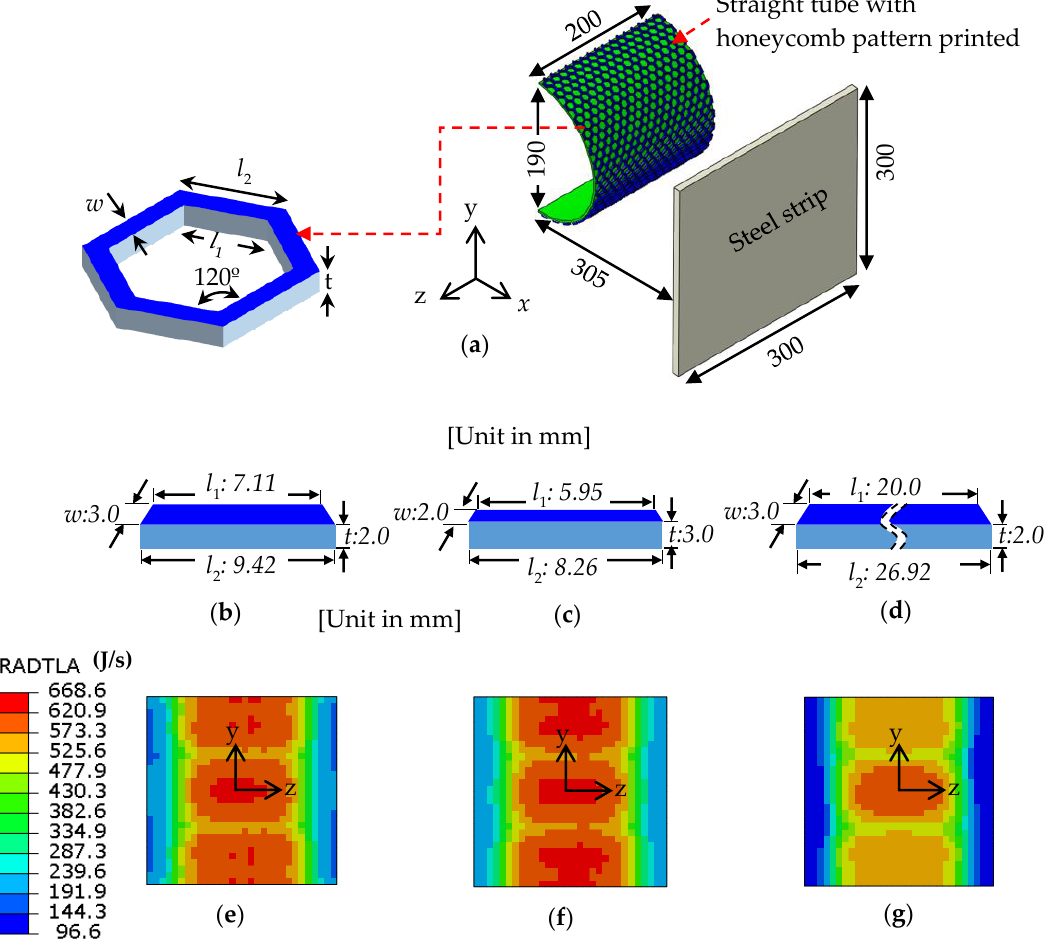
Figure 6. ( a ) Honeycomb design variables ( left ). The partial FE model with honeycomb patterns printed ( right ). ( b – d ) denotes the dimensions of the honeycomb structures used in the FE analysis. ‘ t ’ denotes the height of honeycomb grid in the tube radius direction. ( e – g ) indicate the contour of RADTLA, time integrated radiation heat per unit area (J / s) for three honeycomb structures right above.